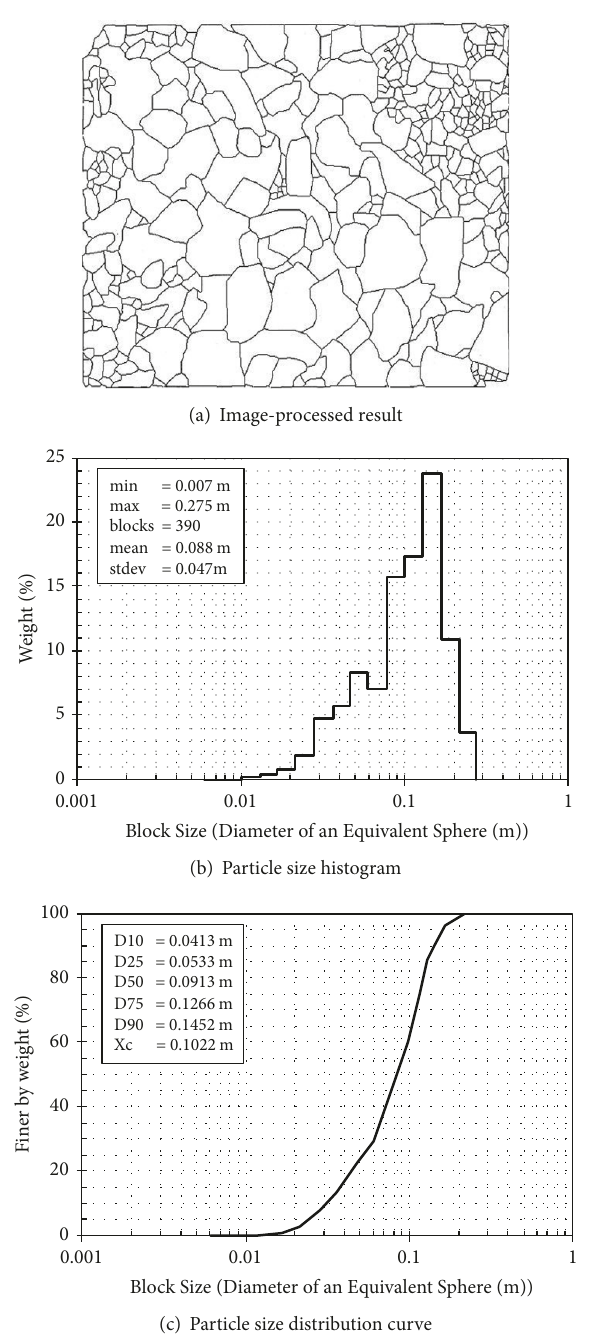
Figure 12: Particle size histogram and particle size distribution curve of blasted rock (WipFrag). (V-cut, Test #5; Min. 0.6cm, Max. 25.3cm, Ave.